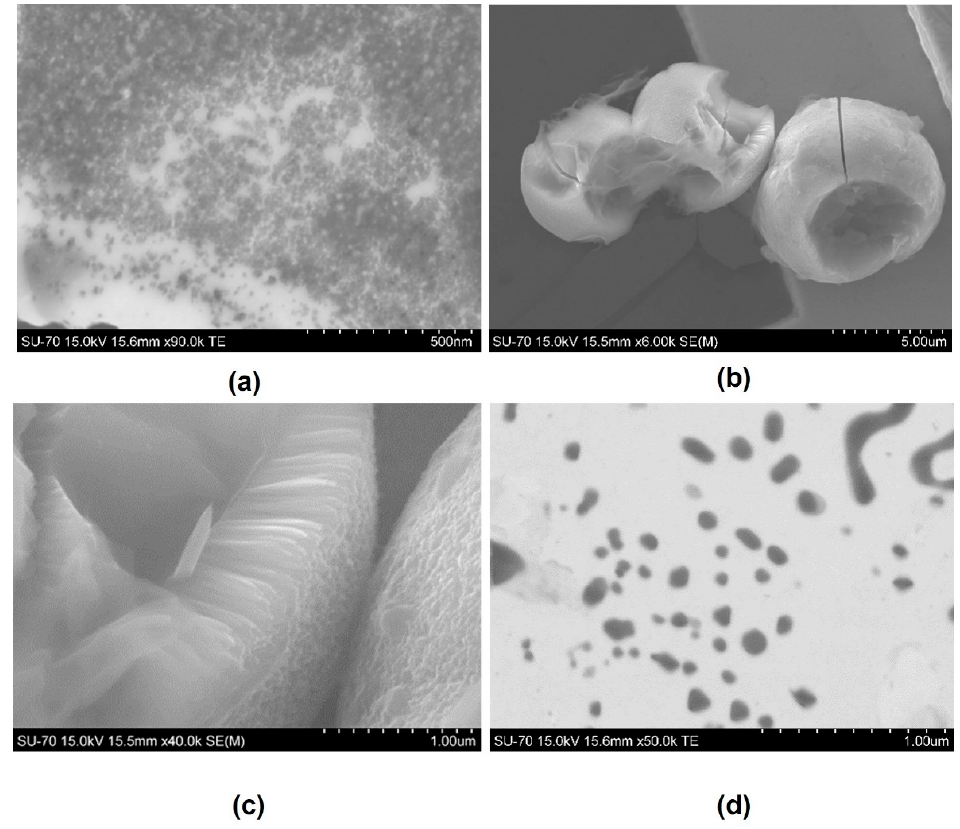
Figure 5. SEM images for ( a ) TiO 2 , ( b , c ) CD@TiO 2 , and ( d ) CD/TiO 2 .